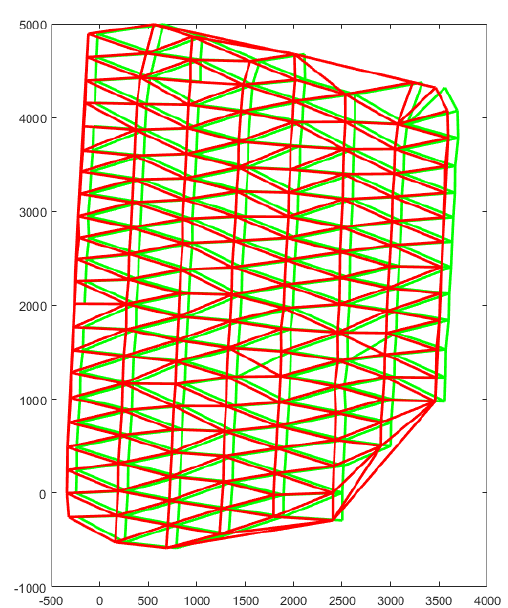
Figure 2.a) Triangulation after 25 images (valid edges in green, rejected edges in blue)